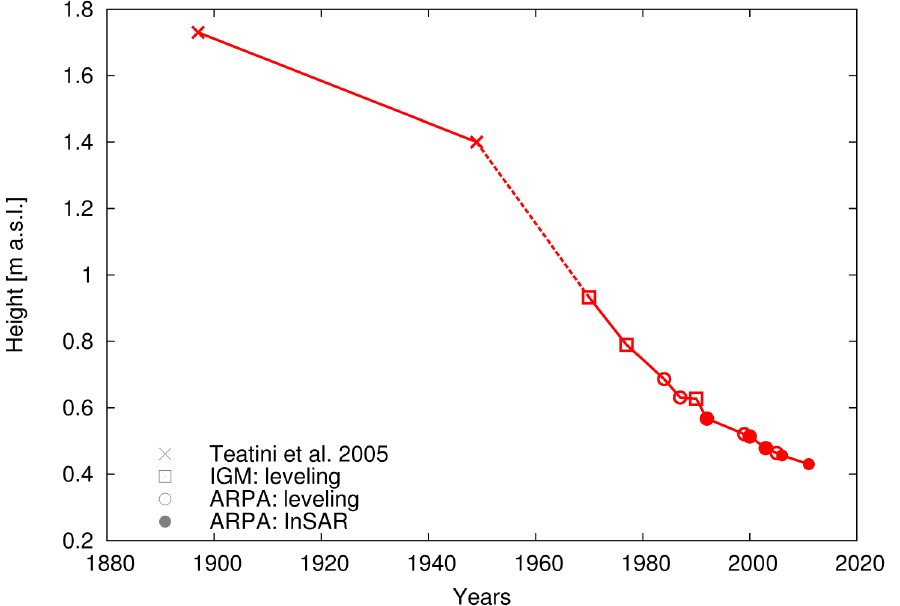
Figure 4. Altitude measurements in Marina di Ravenna at various epochs. Given the various elaborations applied to data before 1970 (see Section 2.2), the association with the 1970 IGM leveling is approximate (dashed line). Data after 1970 refer to different sources and survey methods, marked by various symbols (see legend). Further details are given in Tables 1 and